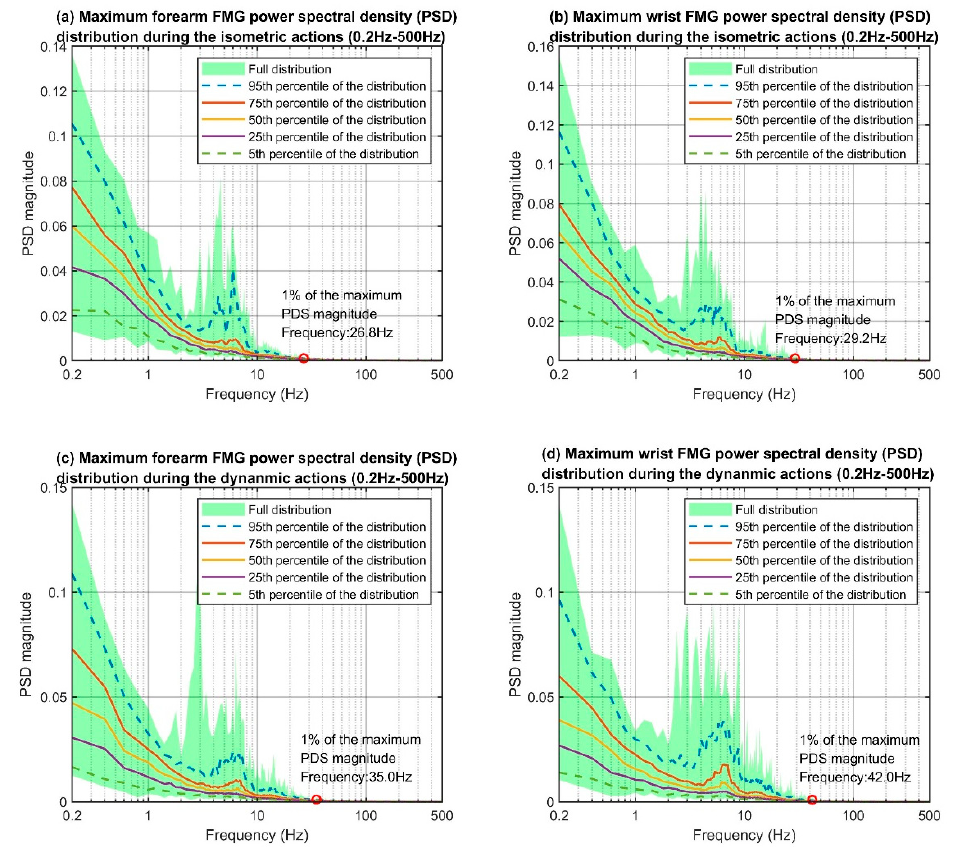
Figure 8. Maximum FMG power spectral density (PSD) distributions.